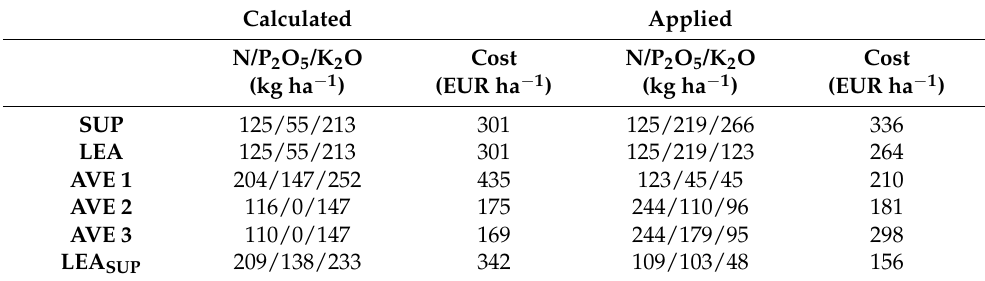
Table 4. Calculated and observed values of fertilizers.